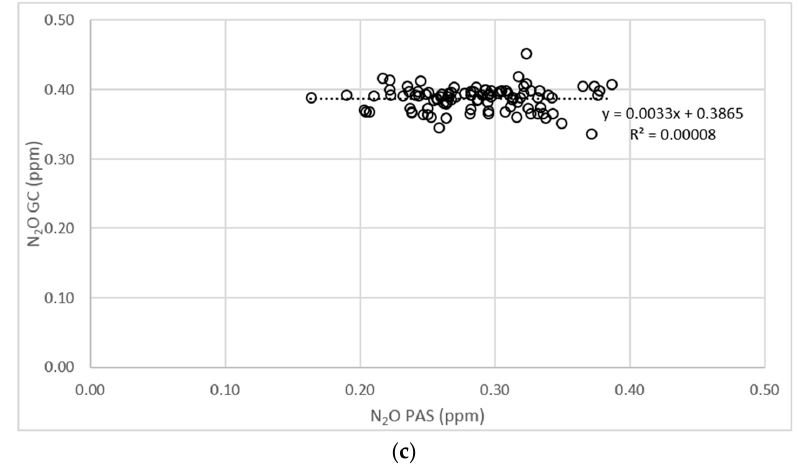
Figure 6. Correlation among CH 4 ( a ), CO 2 ( b ), and N 2 O ( c ) concentrations detected using photoacoustic spectroscopy (PAS) and gas chromatography (GC).